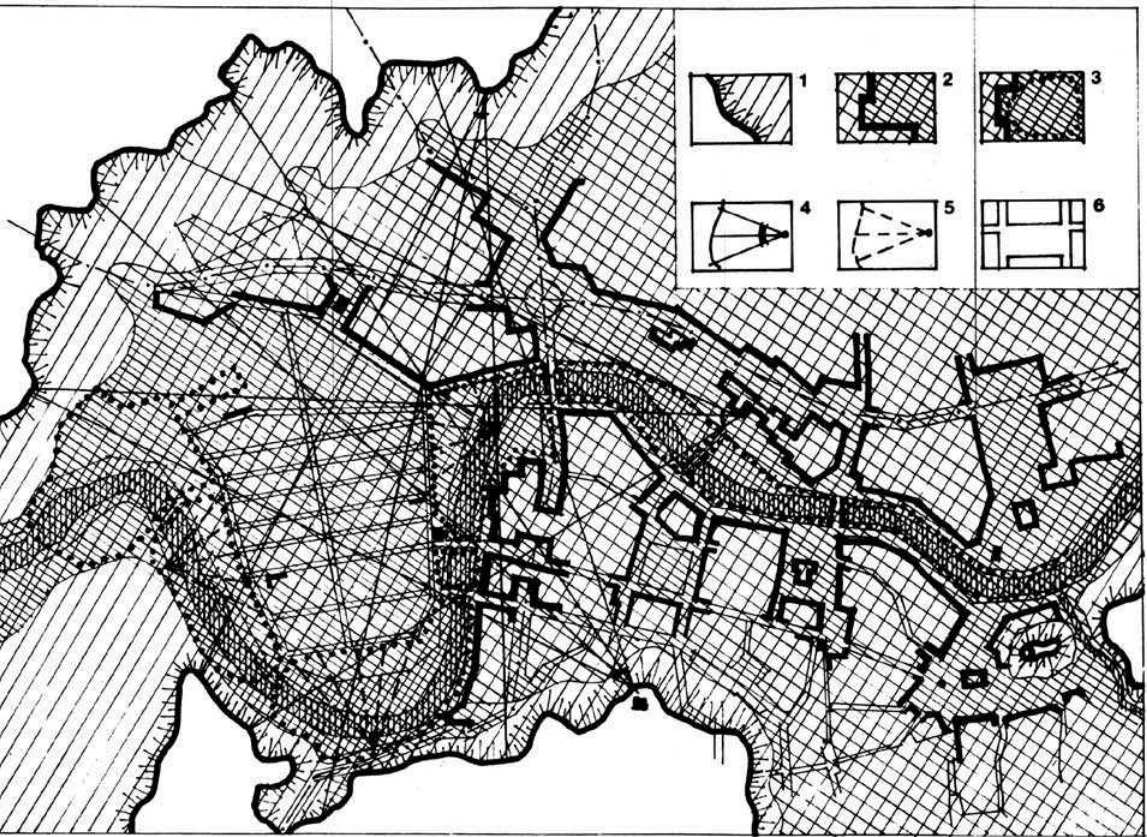
Fig. 10. Structure of visual spaces and links of Žvėrynas and naujamiestis districts in Vilnius. Visual spaces. Prof Dr Z. J. Daunora, 1990.1, 2, 3 – essential urban, regional and local visual links: 4 – panoramic, 5 – low mass